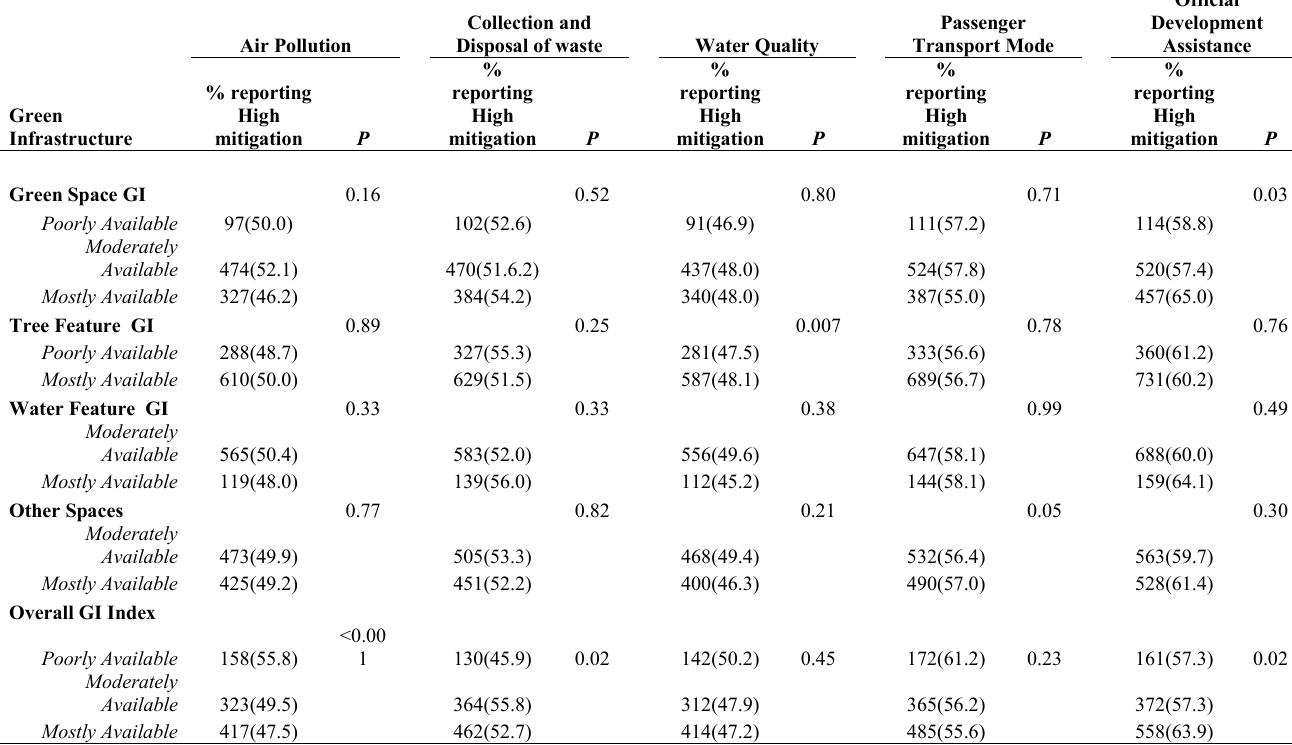
Table 4: Association between Availability of GI and Environmental Sustainability challenges.